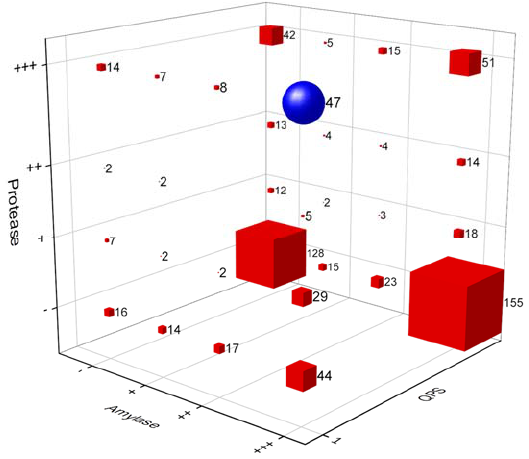
Figure 2. A 3D bubble plot of the primary selection of strains for the fermentation of Abelmoschus manihot , with a qualified presumption of safety (QPS) status among Bacillaceae species with extracellu- lar protease and amylase activity. Blue circle: a group of 47 strains selected for primary fermentation. Values on the X-axis indicate amylase activity, the Y-axis is protease activity, and the Z-axis is the QPS status of the strains. Hydrolase (protease and amylase) enzyme activities were determined based on the agar diffusion method. The activity of the enzymes was measured based on the radius of the halo zone around colonies (+++: >7 mm, ++: 4–6 mm, +: 1–3 mm, -: no activity). Strains with a QPS status are labeled as 1 and other strains are labeled as